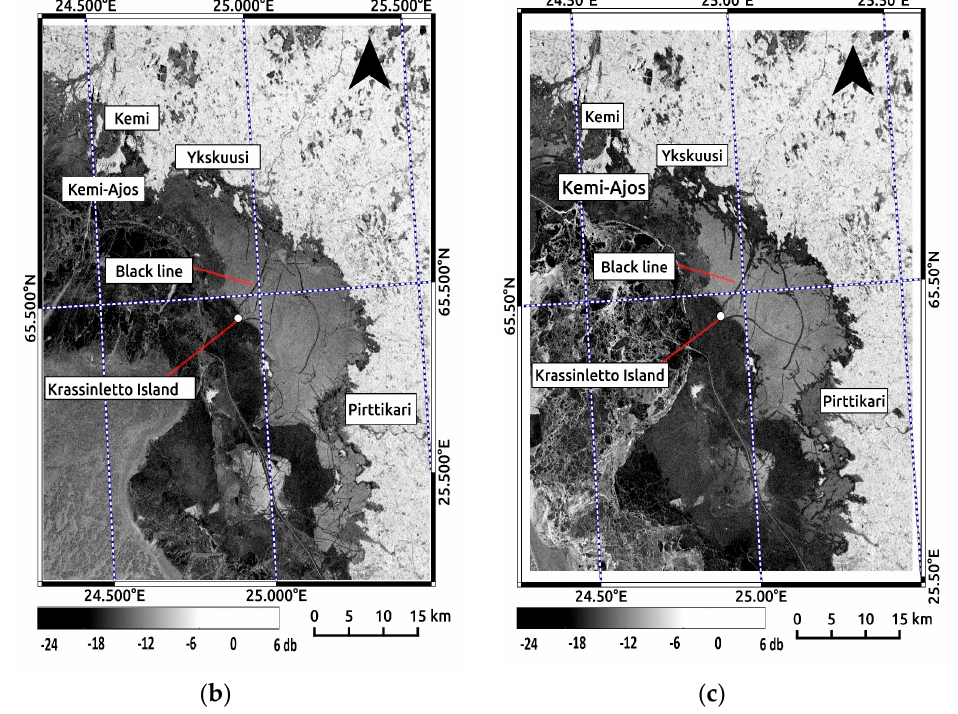
Figure 3. (a) An overview of the Baltic Sea with IW image in this study, showing the enlarged geometry of image IW (IW1, IW2, and IW3). ( b )The IW2 swath from 6 February 2015, with backscatter values in decibels. ( c ) The IW2 swath 18 February 2015, with backscatter values in decibels.